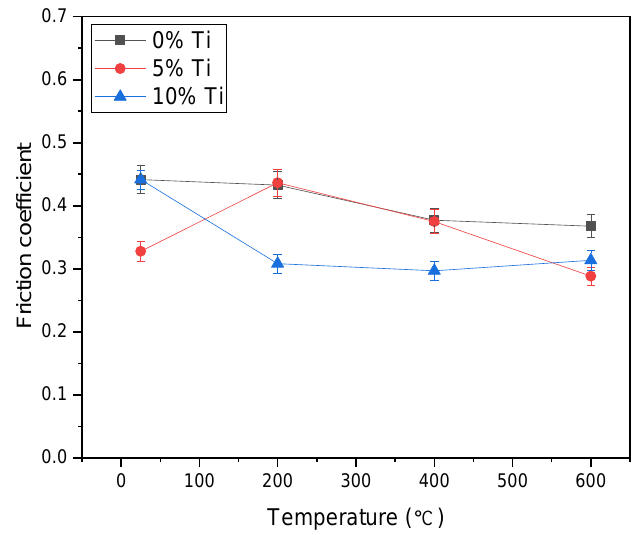
Time (min)25  C Figure 1. Variation curves of friction coefficient of Ni 3 Si alloy with 10% Ti addition against Si 3 N 4 at a load of 10 N and sliding speed of 0.10 m/s. The friction coefficient as a function of temperature for Ni 3 Si alloy is given in Figure 2. As the temperature increased, the friction coefficient of pure Ni 3 Si alloy showed a descending trend. This could be related to the good high-temperature mechanical properties and the oxidation of the alloy